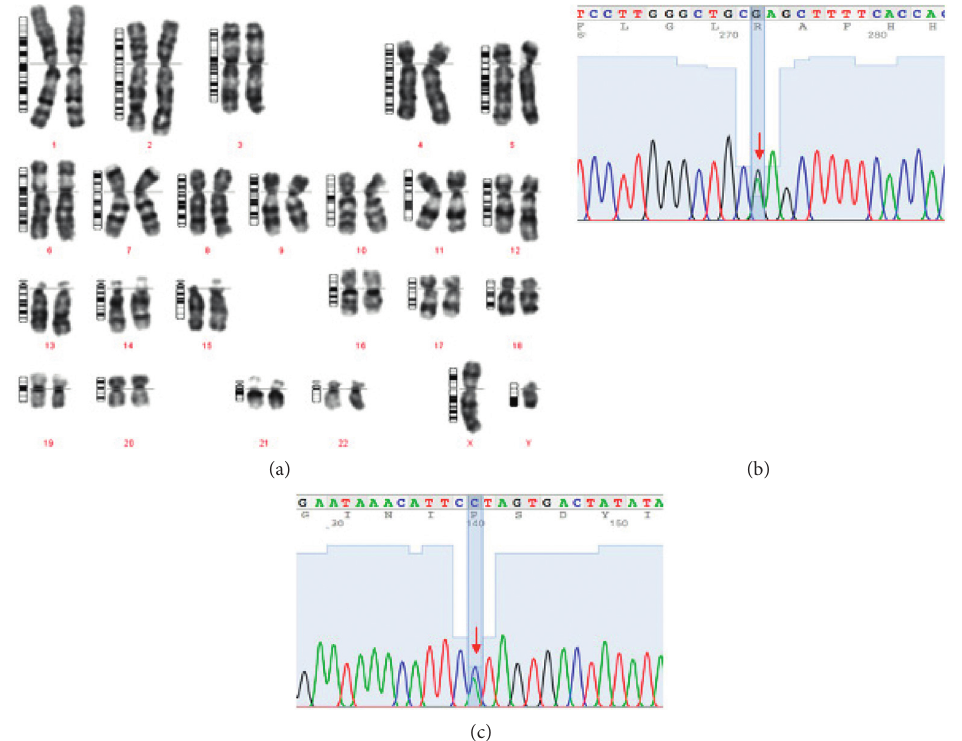
Figure 2: Genetic analysis of the patient. (a) 46,XY karyotype and (b, c) sanger sequencing results revealed c.680G > A (p.Arg227Gln) and c.485A > C (p. His162Pro)